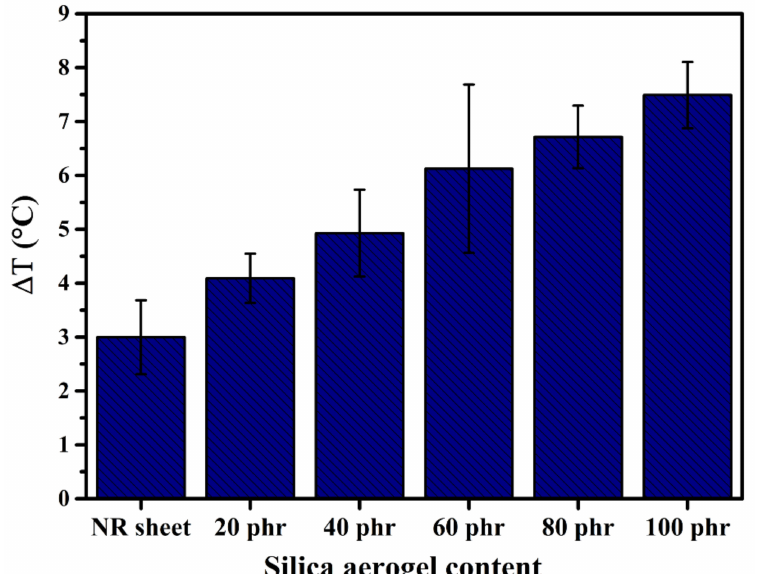
Figure 8. Temperature difference between the temperature of the hotplate and sample surface of silica aerogel/NRL composites in different silica aerogel contents and NR